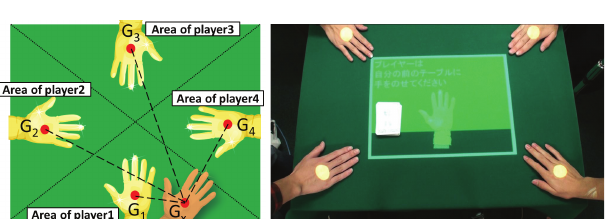
Figure 5. Concept of identifying a player (left), a message to urge players to put their hands on the desk, and the projection to inform players of recognition result (right).